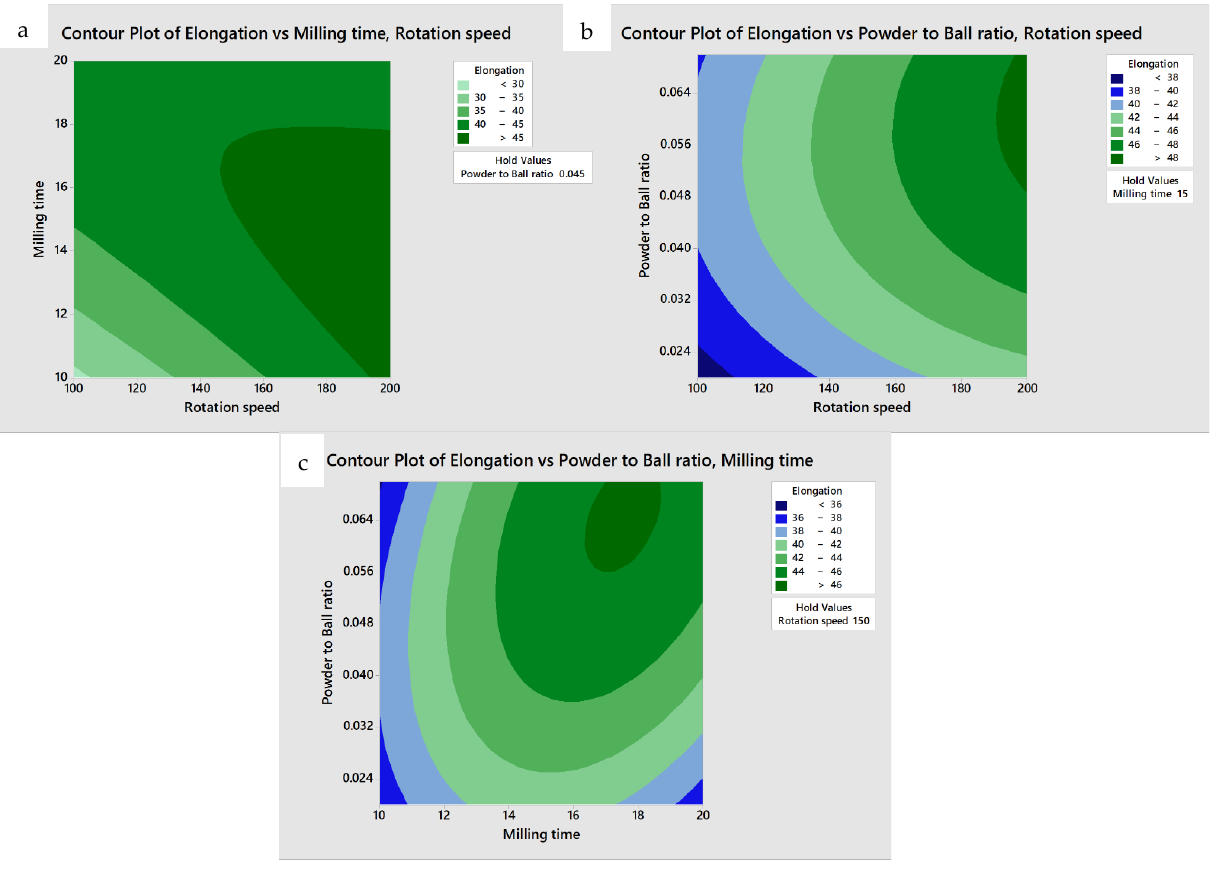
Figure 4. Contour plot of the effect of the ( a ) rotation speed and mechanical milling time, ( b ) rotation speed and powder-to-ball ratio, and ( c ) mechanical milling time and powder-to-ball ratio on elongation.